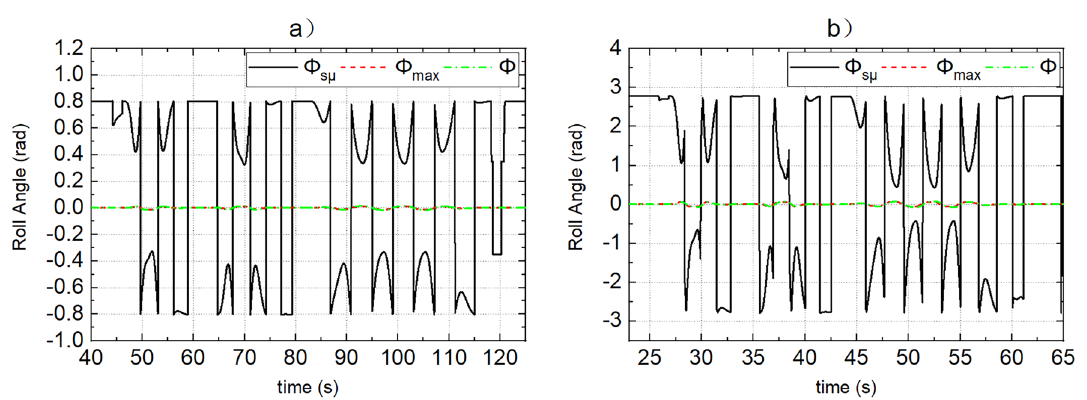
Figure 8. ( a , b ) Represent the response of roll angle of dynamic boundary and actual roll angle when the road adhesion coefficients are 0.15 and 0.8, respectively.